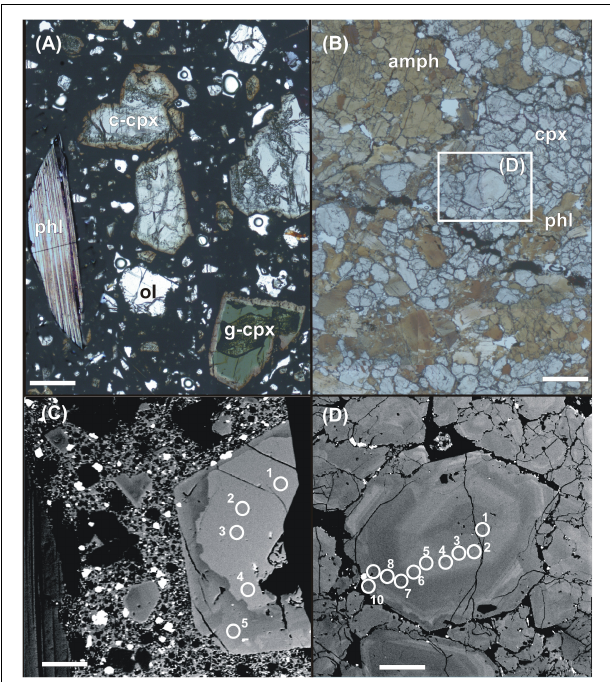
FIGURE 1 | Petrographic characteristics of El Aprisco and Cerro Pelado volcanic rocks (Calatrava Volcanic Field, central Spain). (A) Photomicrograph of an olivine nephelinite from the Cerro Pelado volcano (sample 116596) showing clinopyroxene phenocrysts with relic cores (c-cpx: colorless core, g-cpx: green core) close to phlogopite(phl) and olivine (ol) phenocrysts. (B) Photomicrograph of an amphibole- and phlogopite-rich clinopyroxenite enclave from the El Aprisco volcano (sample 115601). The white bar at the bottom of photomicrographs represents 500 mm. (C) Back-scattered electron (BSE) image of green core (light) clinopyroxene phenocryst with a brownish rim (dark). (D) BSE image of zoned clinopyroxene crystal from clinopyroxenite enclave 115601 of picture B (see marked grain). Circles in BSE images represent laser ablation spots of 116596 CPXV2 and 115601 CPX1 grains, respectively, from Supplementary Table S2 . The white bar at the bottom of each BSE picture (C,D) represents 100